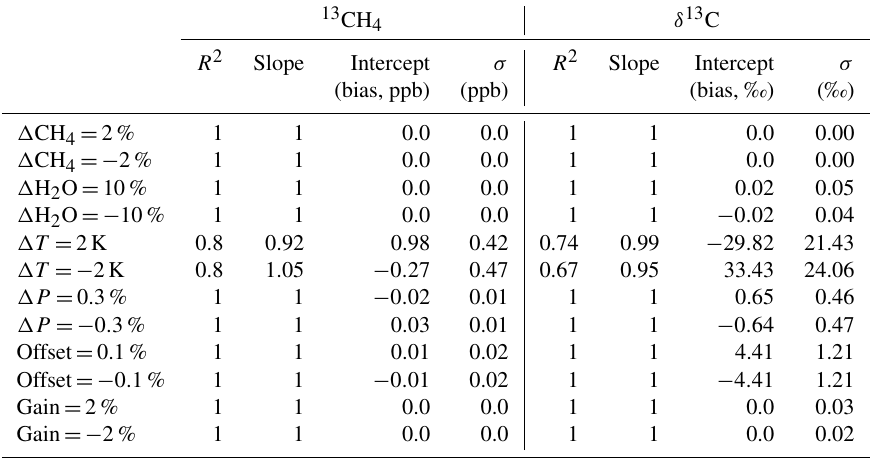
Figure 5. Comparison of retrieved 13 CH 4 (a) and δ 13 C (b) before and after a priori modification by applying a 2% bias on the methane. The red line is a line of best fit, and the statistical characteristics (coefficient of correlation, gradient, intercept and standard deviation of the difference) are indicated in the legend. Table 3. Effects of errors in a priori databases and instrument calibration errors on test retrievals of SWIR1 13 CH 4 and δ 13 C; the metrics displayed in this table are as described in Sect.